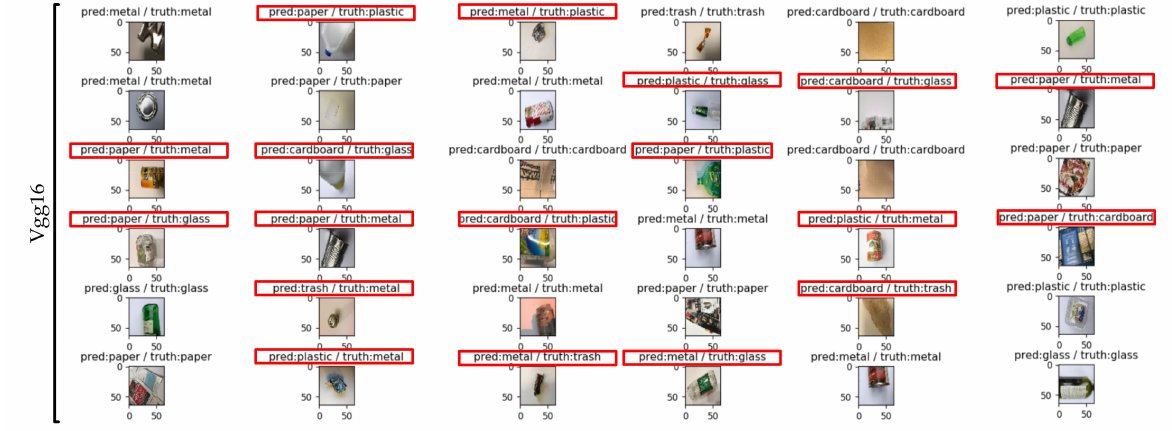
Figure 11. Classification results of the TrashNet set.